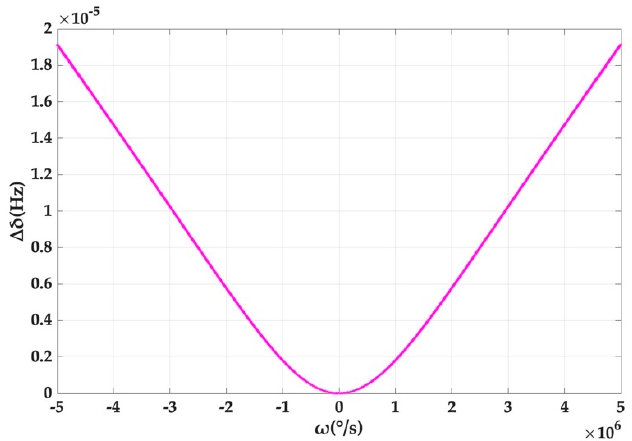
noise introduced at different angular rates.